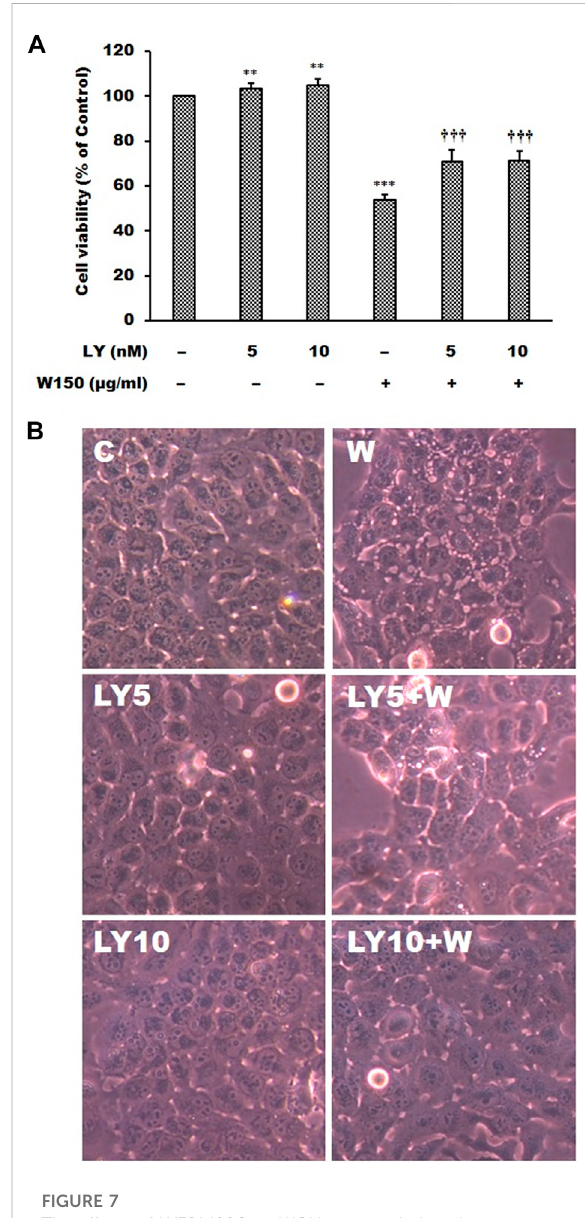
FIGURE 7 The effects of LY3214996 on WGM extracts-induced cell death and membrane-enclosedvacuoles ofHep3Bcells. Cells were pretreated with 5 or 10 nM LY3214996 (LY) for 1 h and then treated with 0.1% DMSO or 150 μ g/ml WGM extracts (W) for 24 h. (A) The effects of LY3214996 on WGM extracts-induced cell death of Hep3B cells. After treatment, the viable cells were measured by MTT assay. All determinations are expressed as the mean % control ±S.D. of duplicate from three independent experiments. ** p < 0.01, *** p < 0.001 compared to the control values. ††† p < 0.001 compared to the WGM extracts alone. (B) The effects of LY3214996 on WGM